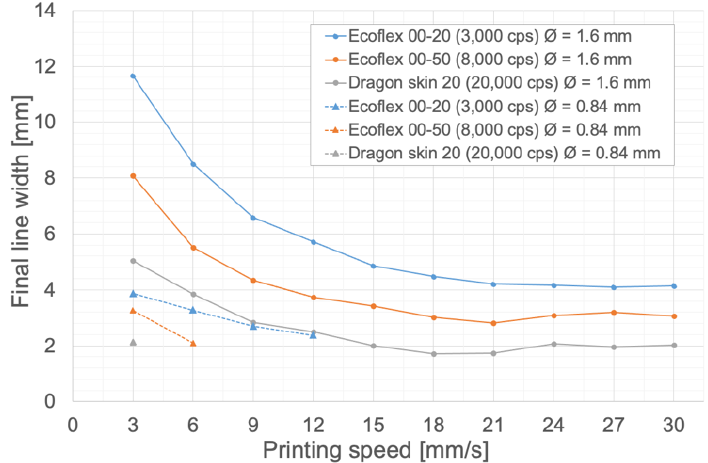
Figure 5. Influence of silicone viscosity and needle diameter on the final line width. Extrusion speed: 0 mm/s. Bed temperature: 90 °C.